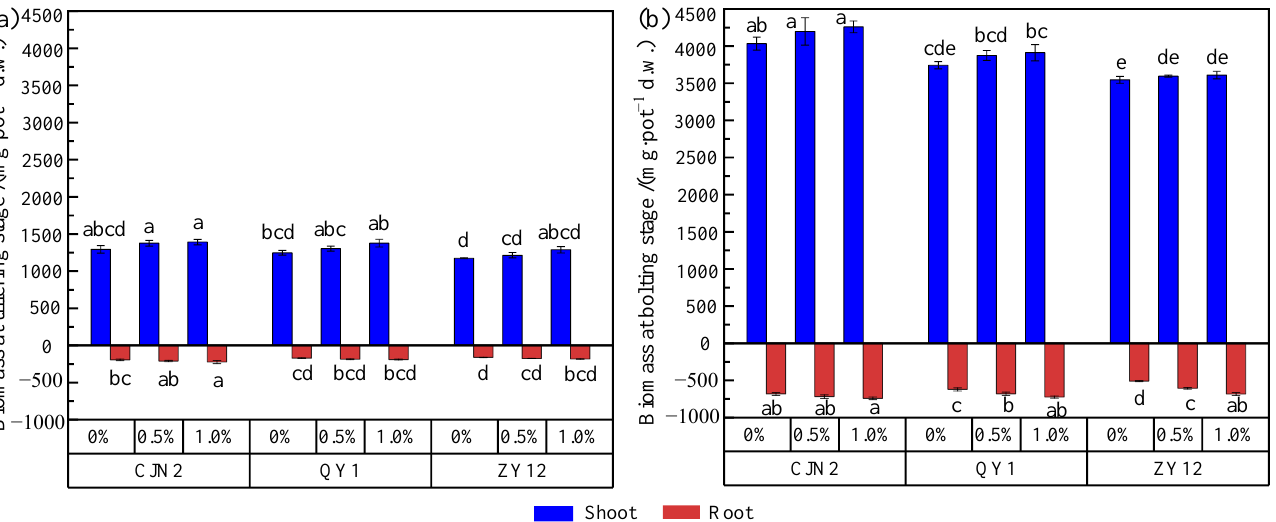
Figure 2. ( a , b ) Effect of red mud (RM) on root and shoot biomass of rice grown in rhizoboxes. Different lowercase letters within shoot or root biomass indicate a significant difference among treatments ( p < 0.05). 0%, 0.5%, and 1% indicated the RM concentrations in soil ( w / w ), the same as below.